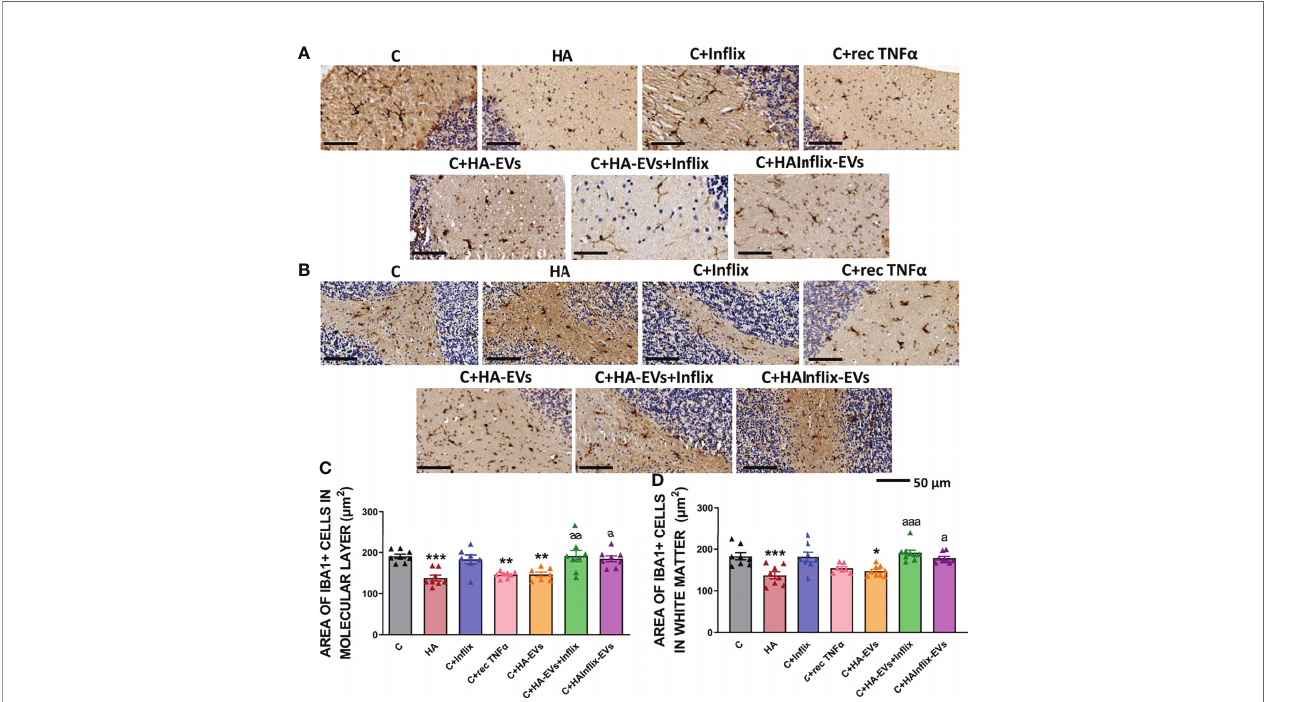
FIGURE 1 | Microglia activation after ex vivo incubation of cerebellar slices from control rats with extracellular vesicles from hyperammonemic rats. Representative images of the immunohistochemistry against Iba1 in cerebellar slices after the ex vivo incubation in (A) molecular layer and (B) white matter. Area of the microglia (Iba1 positive cells) in (C) molecular layer (n=7-8) and (D) white matter (n=7-9). Sample size indicates number of animals. One-way ANOVA with Tukey post-hoc test was performed to compare all groups. Values are the mean±SEM. Values signi fi cantly different from controls are indicated by asterisk (*p<0.05, **p<0.01, ***p<0.001) and values signi fi cantly different from C+HA-EVs group are indicated by a (a=p<0.05, aa=p<0.01, aaa=p<0.001). Scale bar = 50 µm. Experimental groups: cerebellar slices from control (C) and hyperammonemic rats (HA) incubated in basal conditions. Cerebellar slices from control slices incubated with the following treatments: the anti-TNF a In fl iximab (C+In fl ix); recombinant TNF a (C +rec TNF a ); extracellular vesicles from hyperammonemic rats (C+HA-EVs); extracellular vesicles from hyperammonemic rats previously incubated with In fl iximab (C+HA-EVs +In fl ix); extracellular vesicles from hyperammonemic rats treated in vivo with In fl iximab (C+HAIn fl